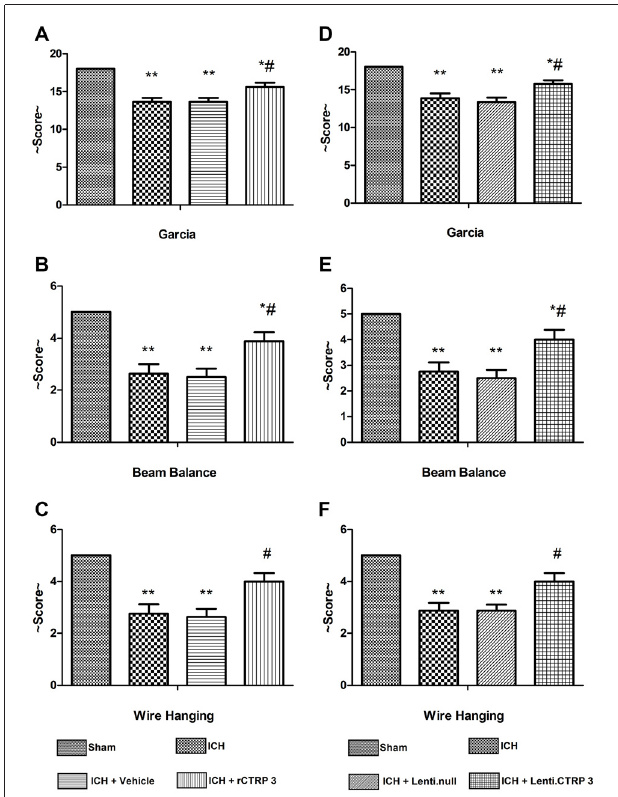
FIGURE 2 | Effects of CTRP3 treatment on neurological functions 7 days after ICH. All animals after ICH showed significant neurological deficits based on performance on the modified Garcia (A) , beam balance (B) and wire hanging (C) tests. Rats treated with rCTRP3 showed reduced neurological deficits in all three tests. Treatment with Lenti-CTRP3 starting 2 weeks before induction of ICH showed a tendency to ameliorate neurological deficits (D–F) . Values are mean ± SEM. n = 9 per group. ∗ p < 0.05 vs. sham; ∗∗ p < 0.01 vs. sham; # p < 0.05 vs. vehicle or Lenti.null. CTRP3, C1q/tumor necrosis factor-related protein-3; rCTRP3, recombinant CTRP3; Lenti-CTRP3, Lentivirus overexpression of CTRP3; ICH, intracerebral hemorrhage.